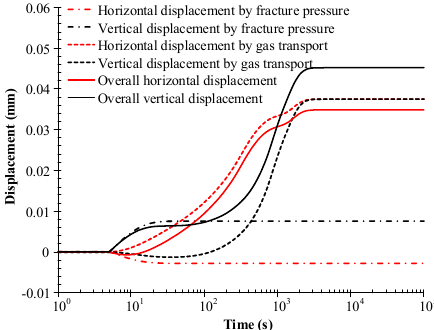
Figure 7. Temporal evolution of the bulk deformation of the representative component geometry.